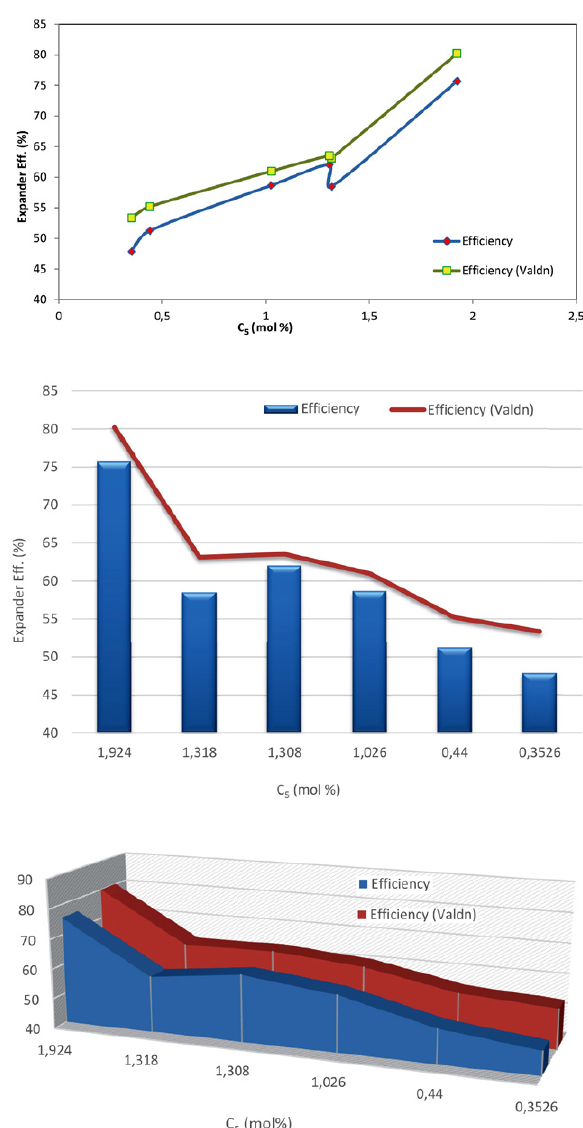
Fig. 4. Effect of Pentane Concentration Variation on Expander Effi- ciency